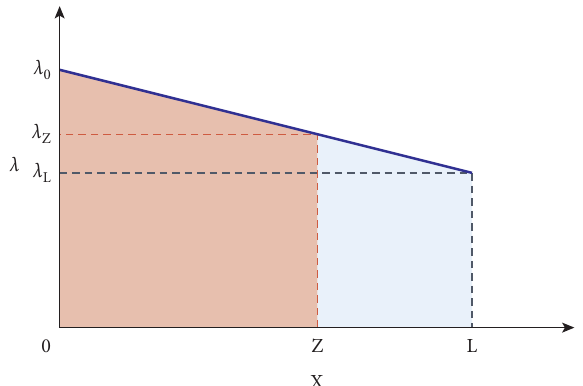
Figure 12: A general trend of the demand density along ( x ) (for the interpretation of the references to colour in this figure legend, the reader is referred to the web version of this